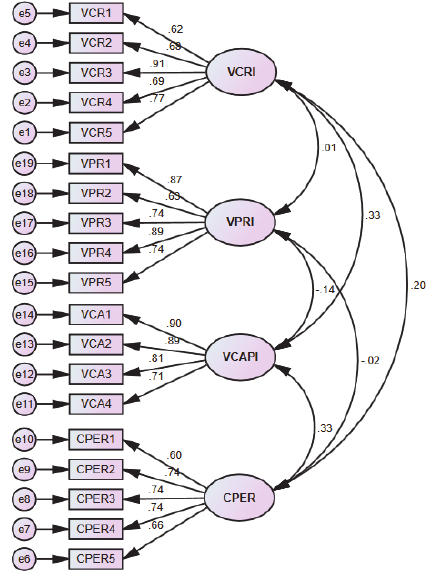
Fig. 2. Research measurement